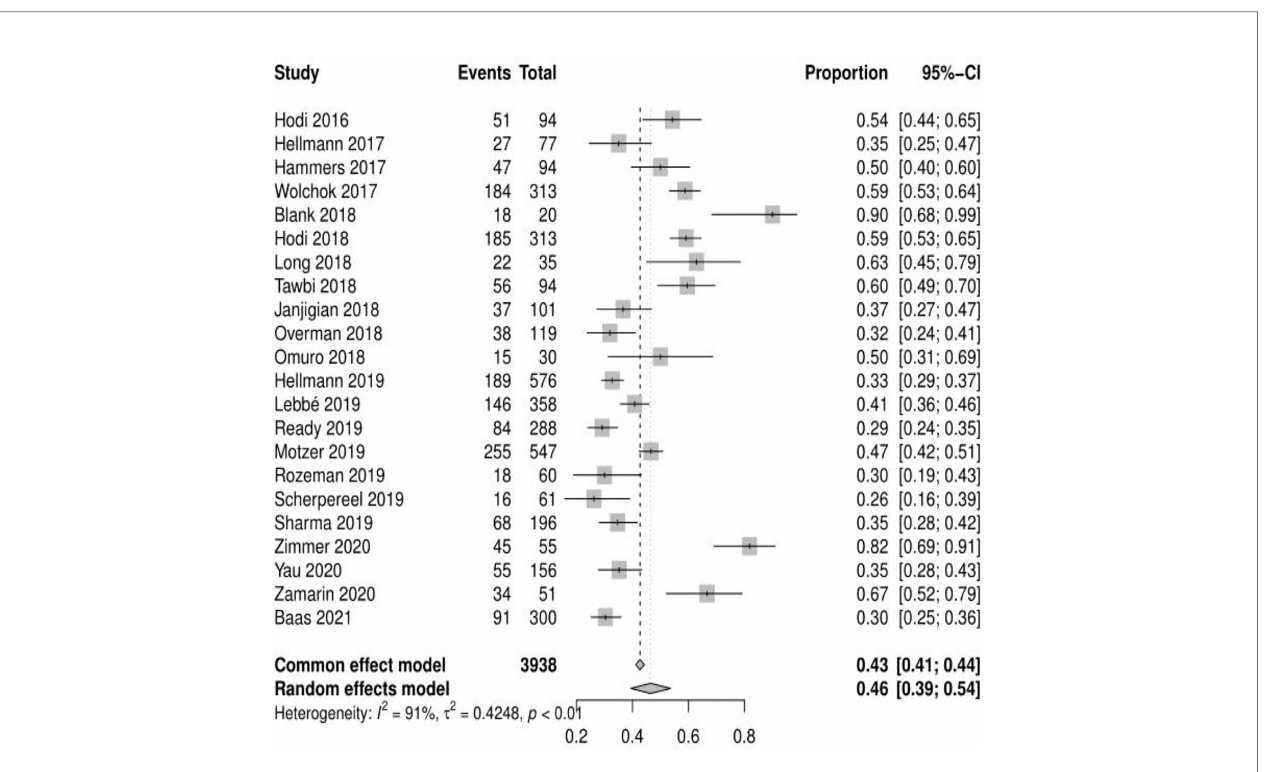
FIGURE 3 | Forest plot of grade 3 or higher adverse